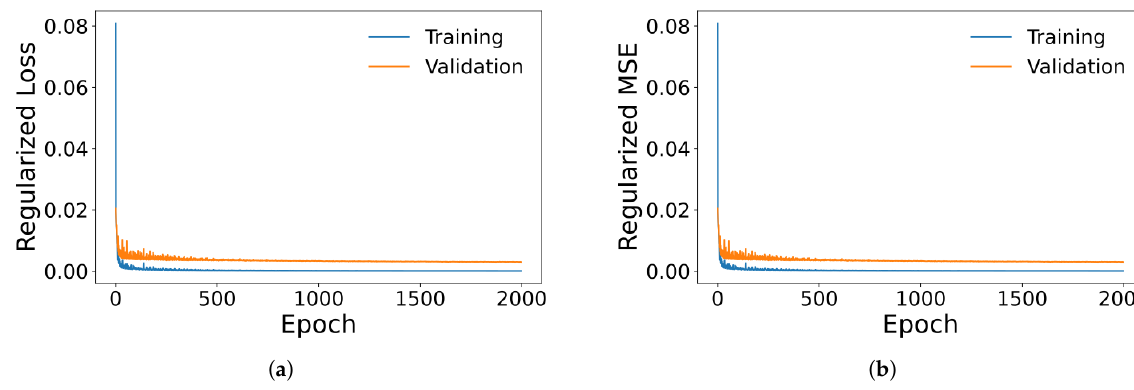
Figure 11. Variation of ( a ) regularized loss as a function of epochs for training and validation data ( b ) regularized MSE as a function of epochs for training and validation